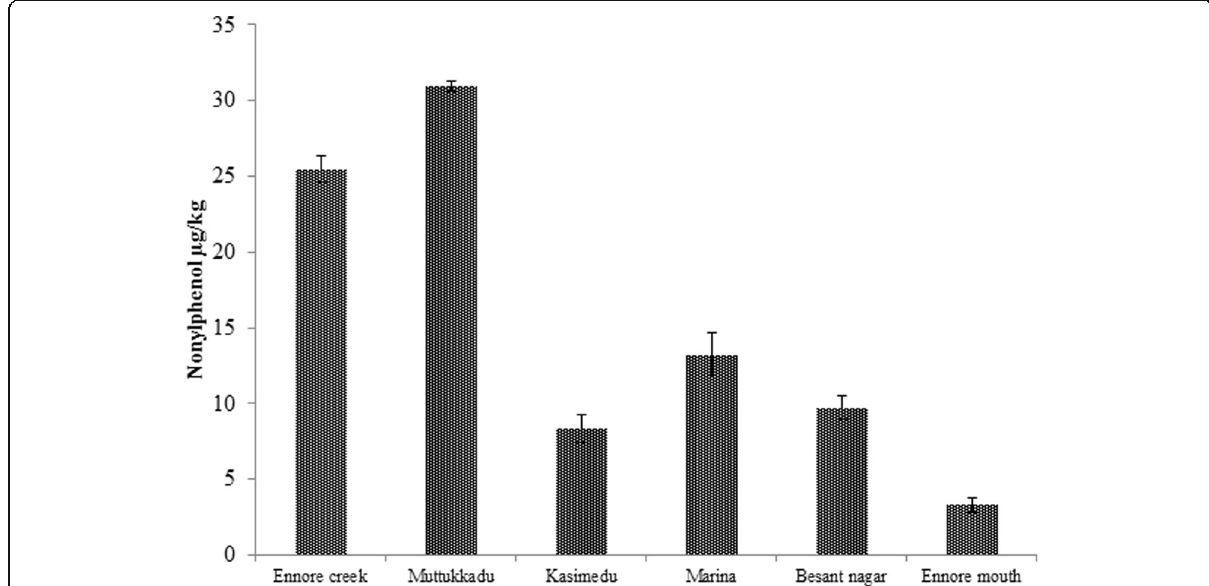
Fig. 3 Concentration of nonylphenol in sediment samples collected from six